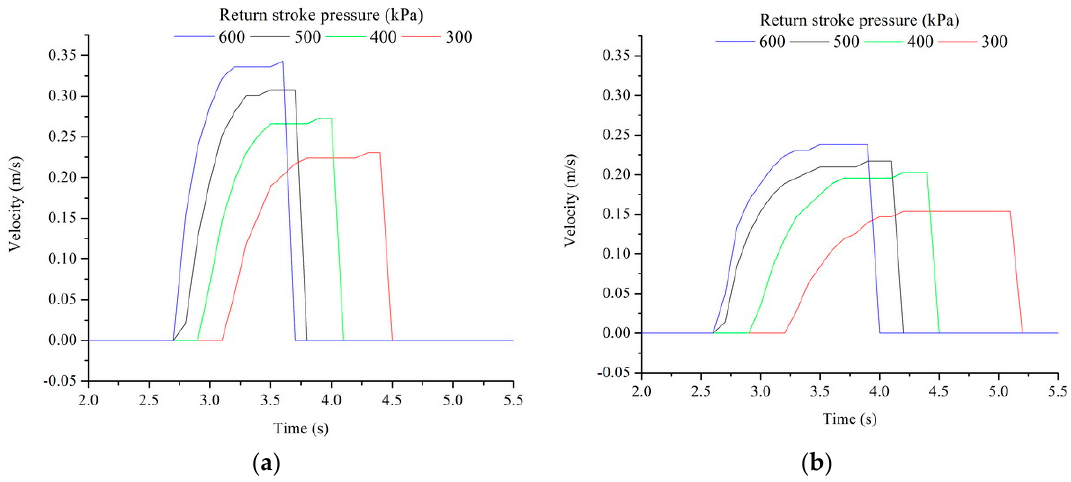
Figure 5. Velocity of cylinder piston movement. Diameter of cylinder: ( a ) 100 mm; ( b ) 125 mm.